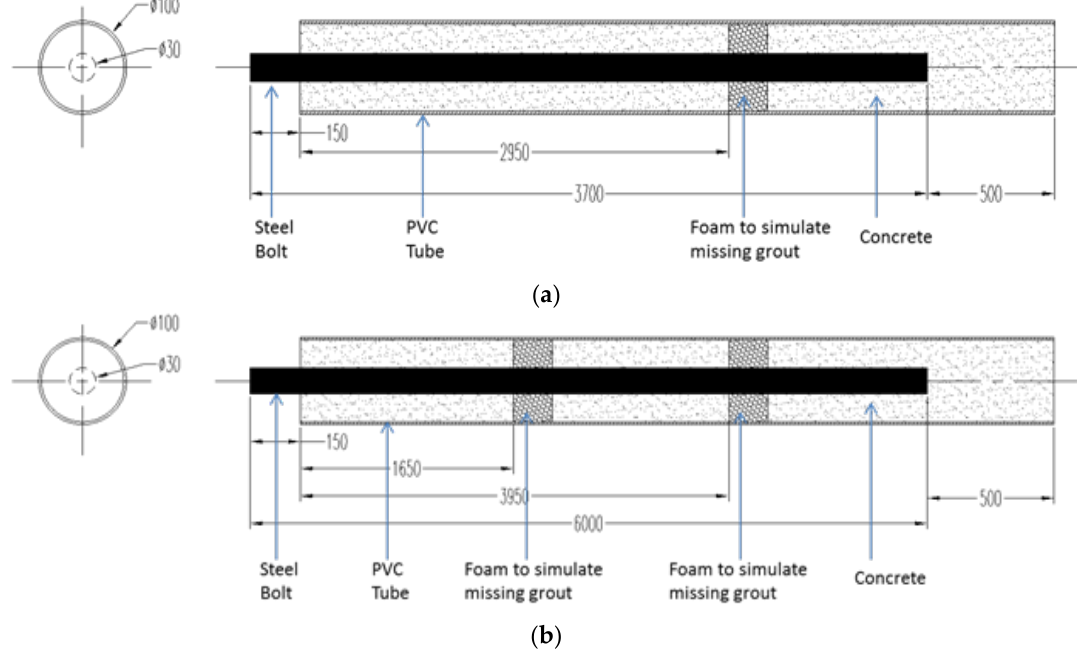
Figure 9. Illustrations of rock bolt specimens. ( a ) Specimen no. 1; ( b ) Specimen no. 2. PVC. Table 2. Parameters of the specimens.